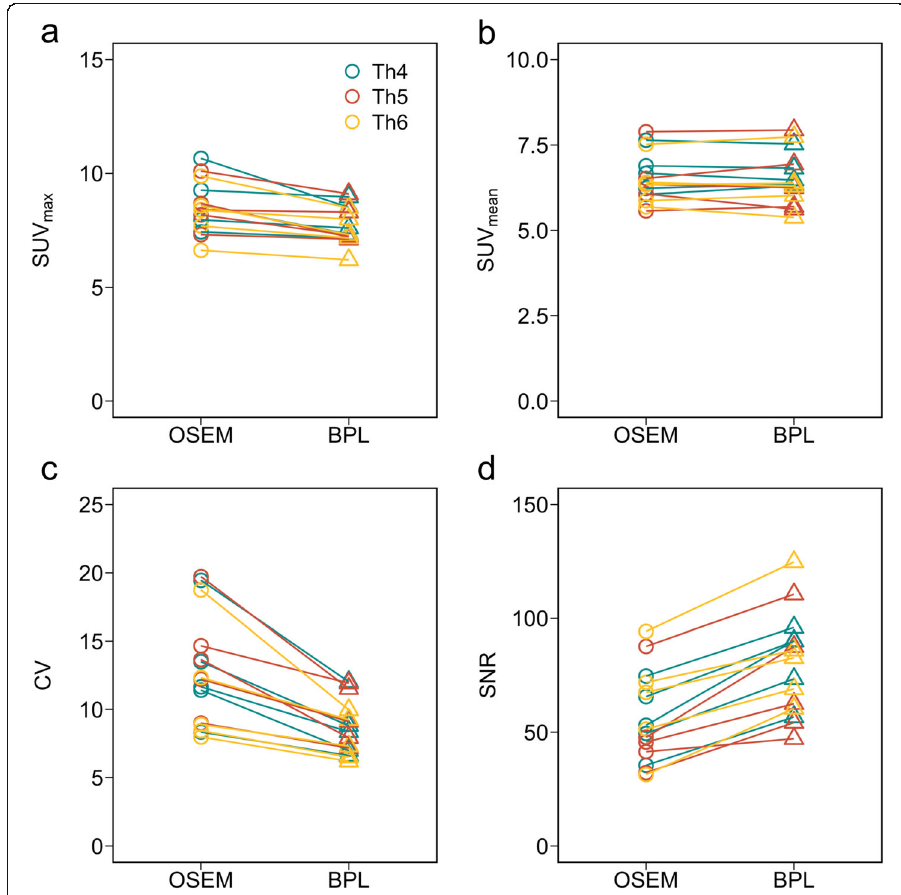
Fig. 8 Clinical comparisons of a SUV max , b SUV mean , c CV, and d vertebral SNR under optimal reconstruction conditions (OSEM, 2 iterations; BPL, β value,